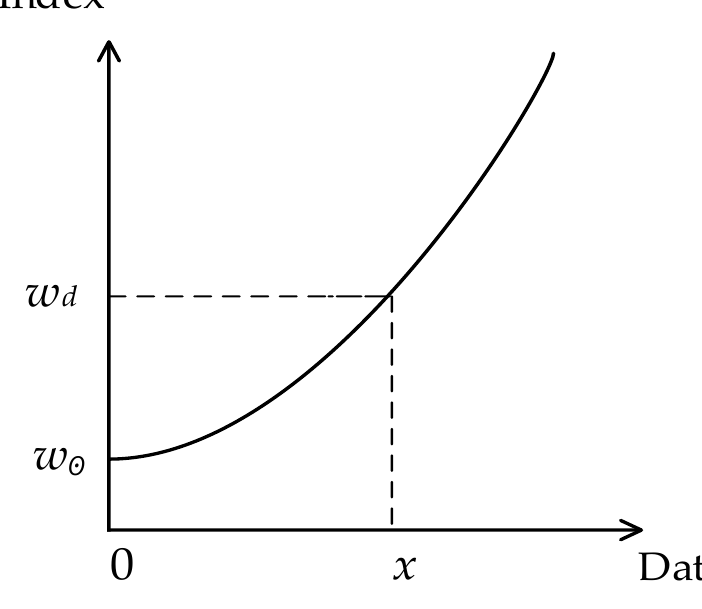
Figure 2. Dynamic weight change pattern.